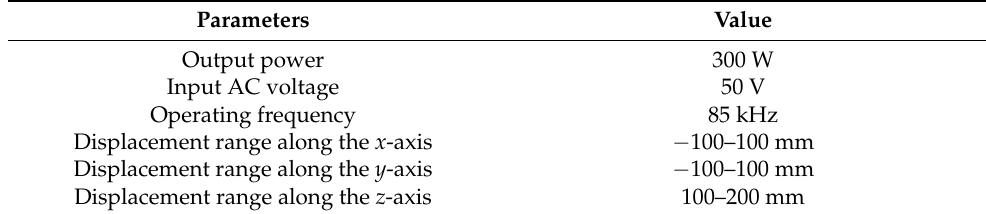
Table 4. Parameters of the experimental setup.